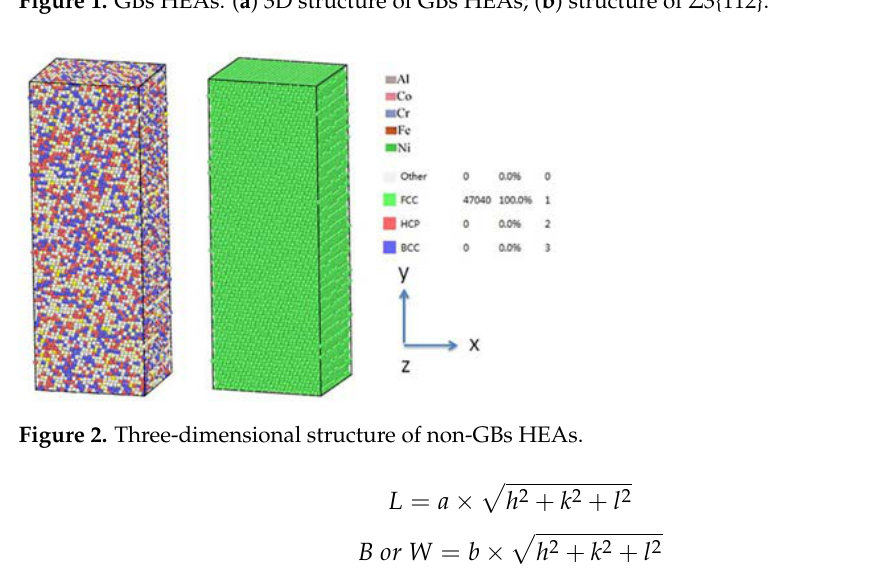
Figure 1. GBs HEAs. ( a ) 3D structure of GBs HEAs; ( b ) structure of Σ 3{112}.